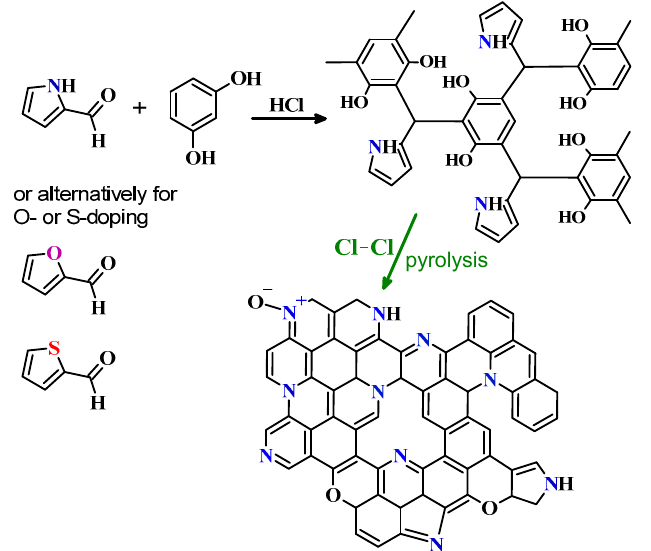
Figure 1. Schematic representation of the polycondensation reaction, the cross-linked polymer structure, the utilized heteroaromatic aldehydes, and pyrolysis under chlorine.